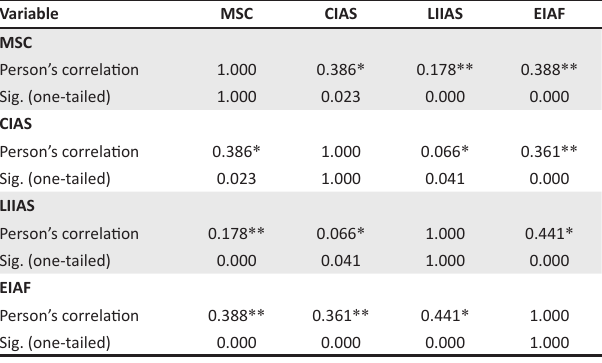
TABLE 4: Correlation analysis of the variables.